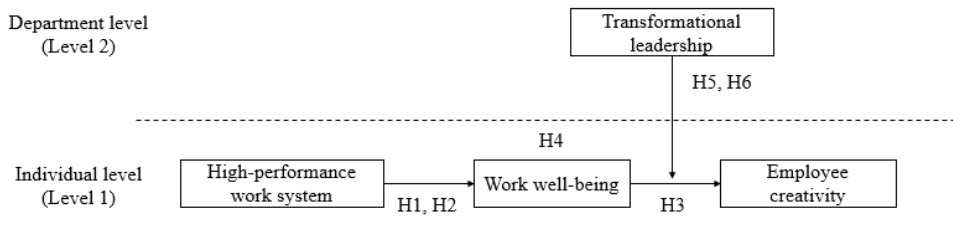
Figure 1. Research Figure 1. Research model.